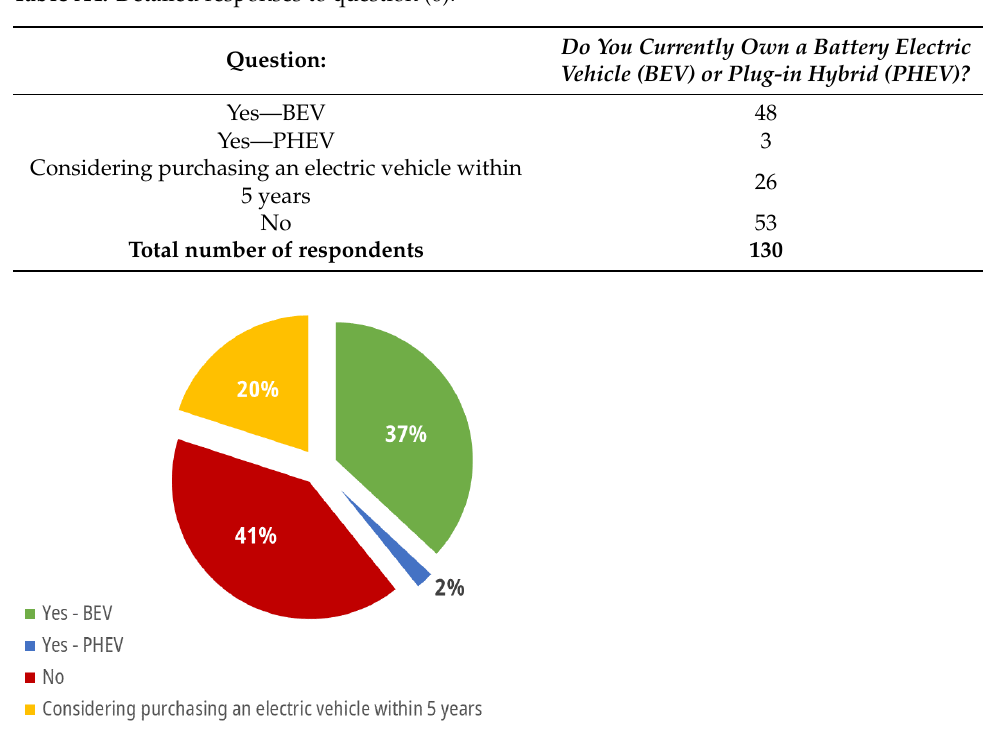
Figure A3. Responses to question (6).